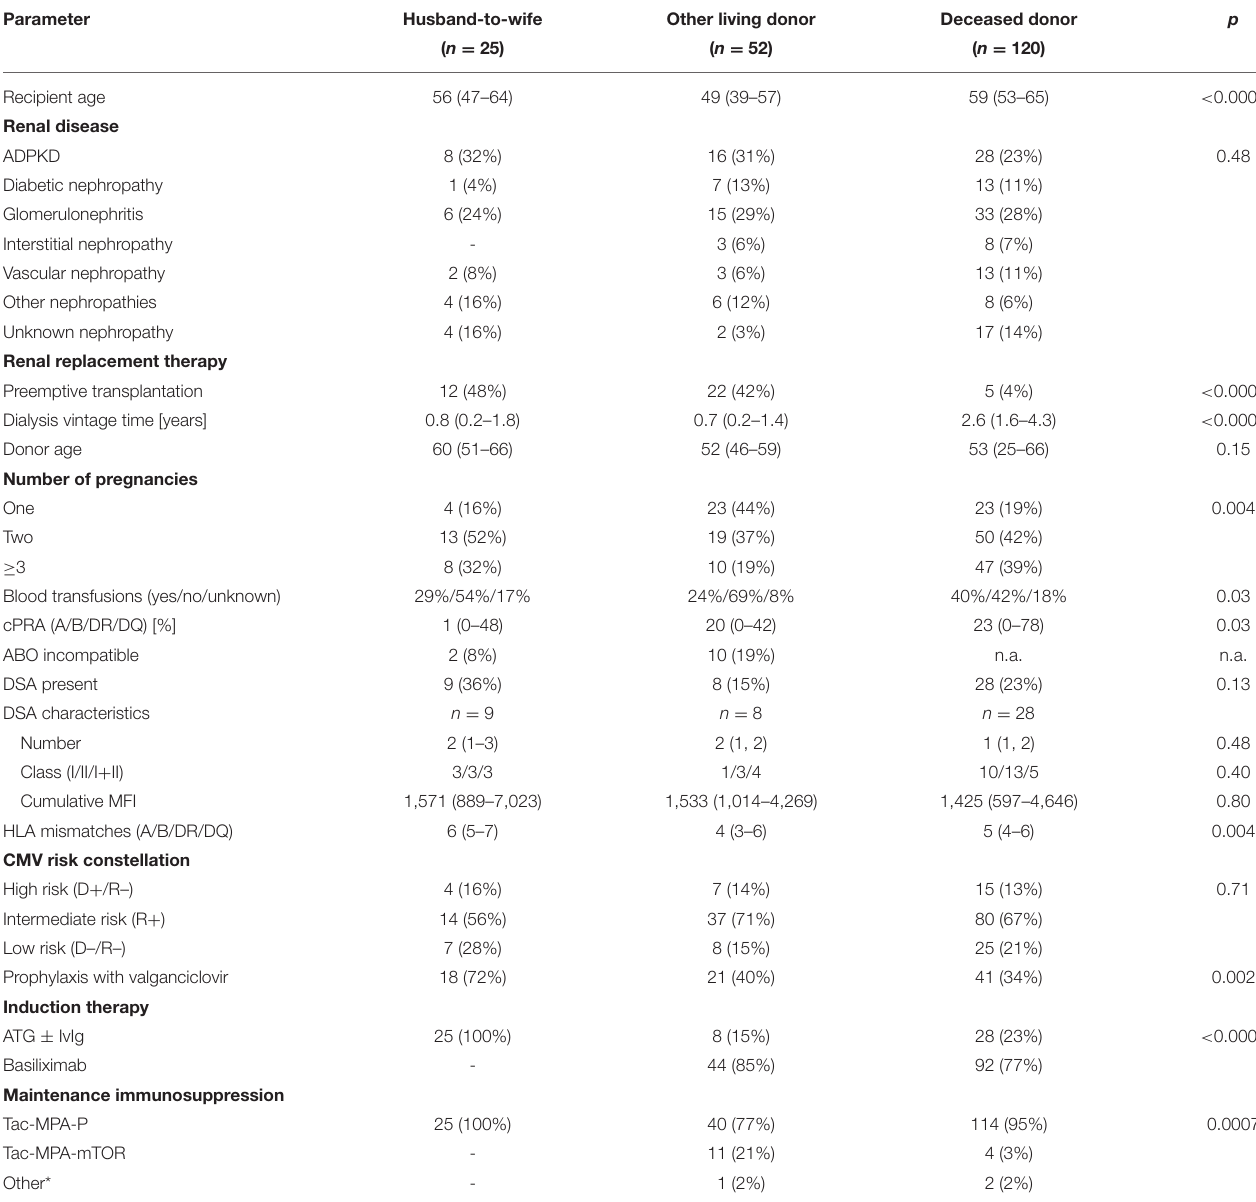
TABLE 1 | Baseline